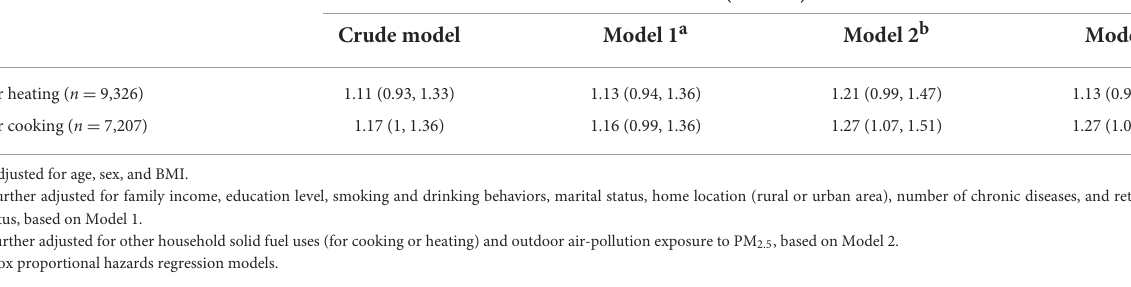
TABLE 3 Associations between purposes of solid fuel use and stroke